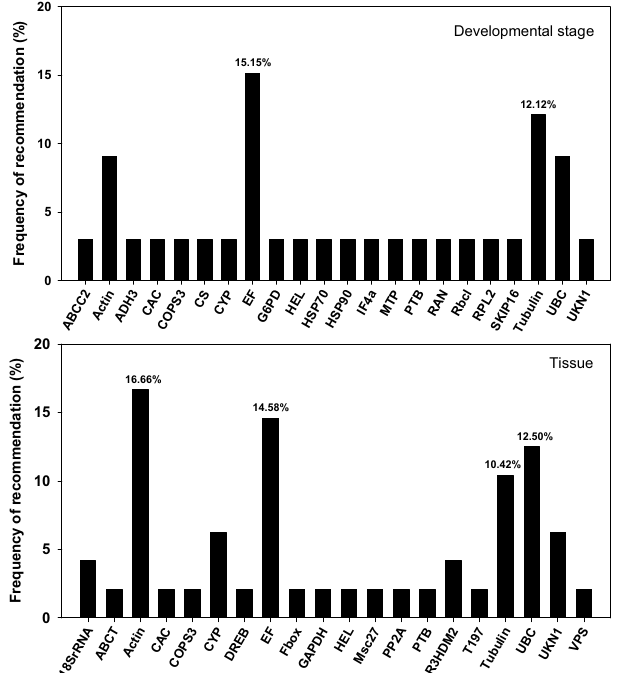
Figure 6. Frequency of reference genes recommended for RT-qPCR analysis under different conditions in Leguminosae plants. Here we surveyed the frequency of each reference gene recommended for different developmental stages and different tissues among the twelve Leguminosae species. Reference genes (top three) recommended for each species under different developmental stages and tissues are detailed in Table